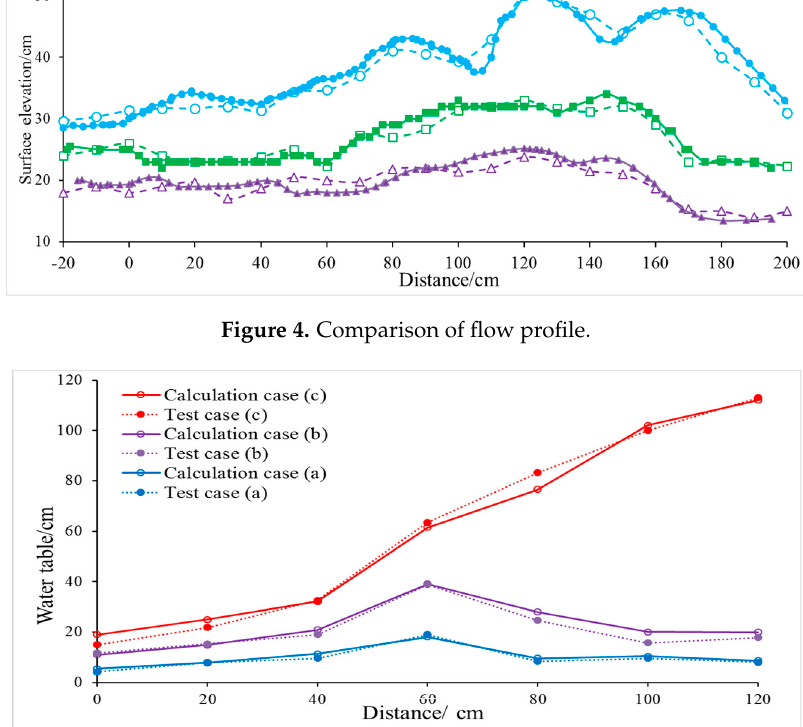
Figure 5. Comparison of average pressure.